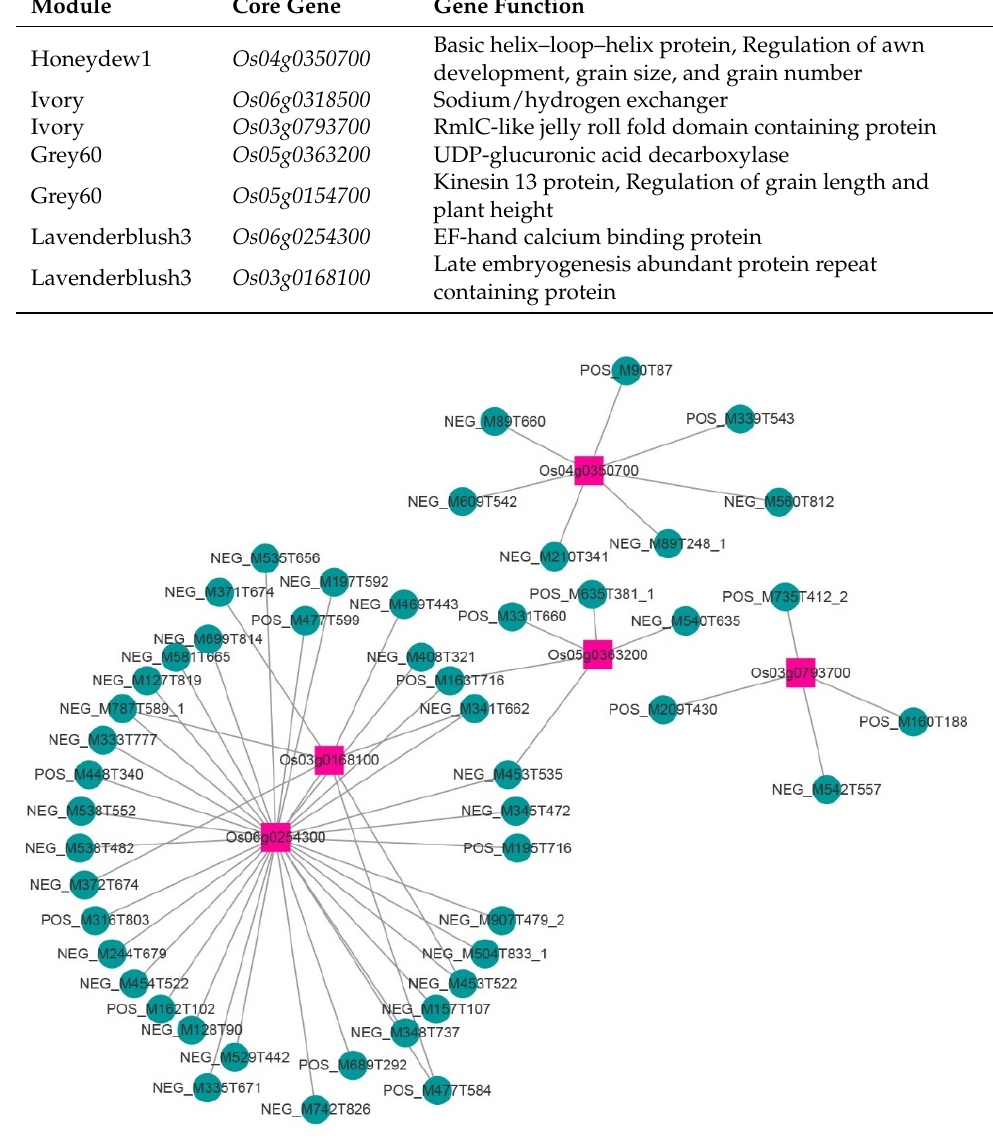
Figure 6. qRT ‒ PCR validation of the seven genes from RNA-seq analysis. ( A ) Relative mRNA ex- pression level of Os04g0350700 gene. ( B ) Relative mRNA expression level of Os06g0318500 gene. ( C ) Relative mRNA expression level of Os03g0793700 gene. ( D ) Relative mRNA expression level of Os05g0363200 gene. ( E ) Relative mRNA expression level of Os05g0154700 gene. ( F ) Relative mRNA expression level of Os06g0254300 gene. ( G ) Relative mRNA expression level of Os03g0168100 gene.